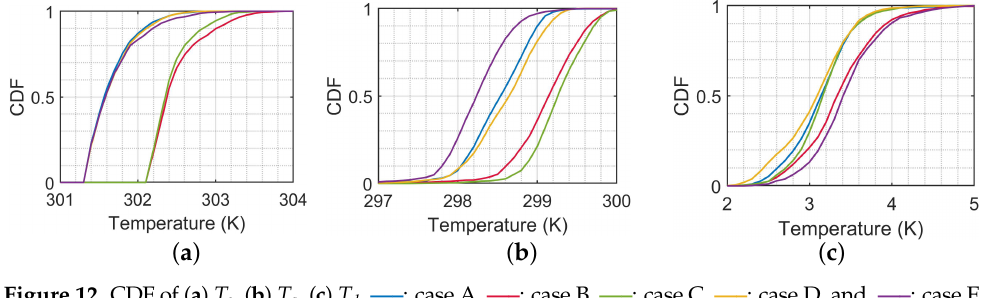
Figure 12. CDF of ( a ) T s , ( b ) T a , ( c ) T d , —– : case A, —– : case B, —– : case C, —– : case D, and —– : case E.